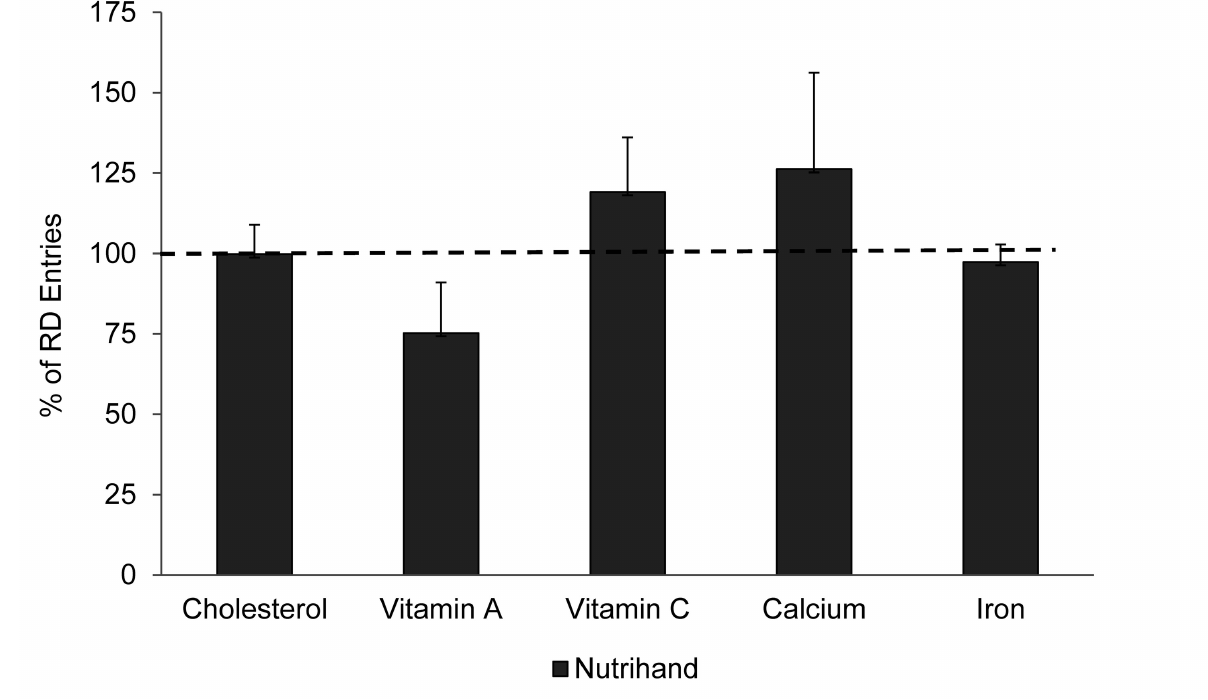
Figure 2. Percentage agreement between electronic methods of diet recording and dietitian-entered 3-day diet record (DR) comparing Nutrihand to values obtained from Grand Forks Research Analysis of Nutrient Data